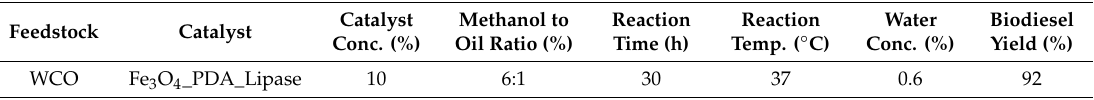
Optimum reaction conditions for biodiesel production from Fe 3 O 4 -PDA-Liapase catalysed